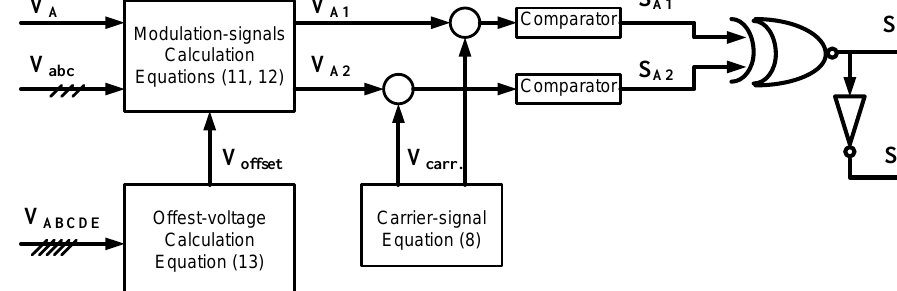
Figure 4. The IMC ’ s inverter-CBPWM stage ’ s block diagram. Figure 4. The IMC’s inverter-CBPWM stage’s block